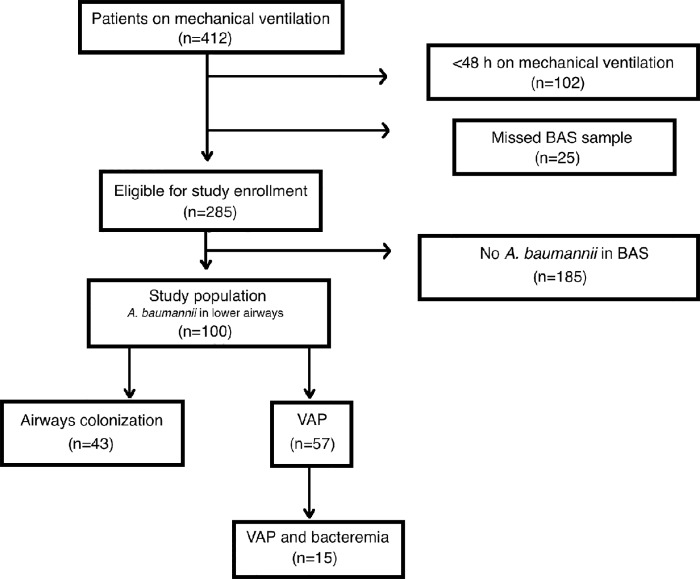
Flow chart on the enrollment of patients in the study and final classification as ventilator-associated pneumonia (VAP) or colonization in those with isolation of Acinetobacter baumannii in trachea-bronchial aspirate (BAS).